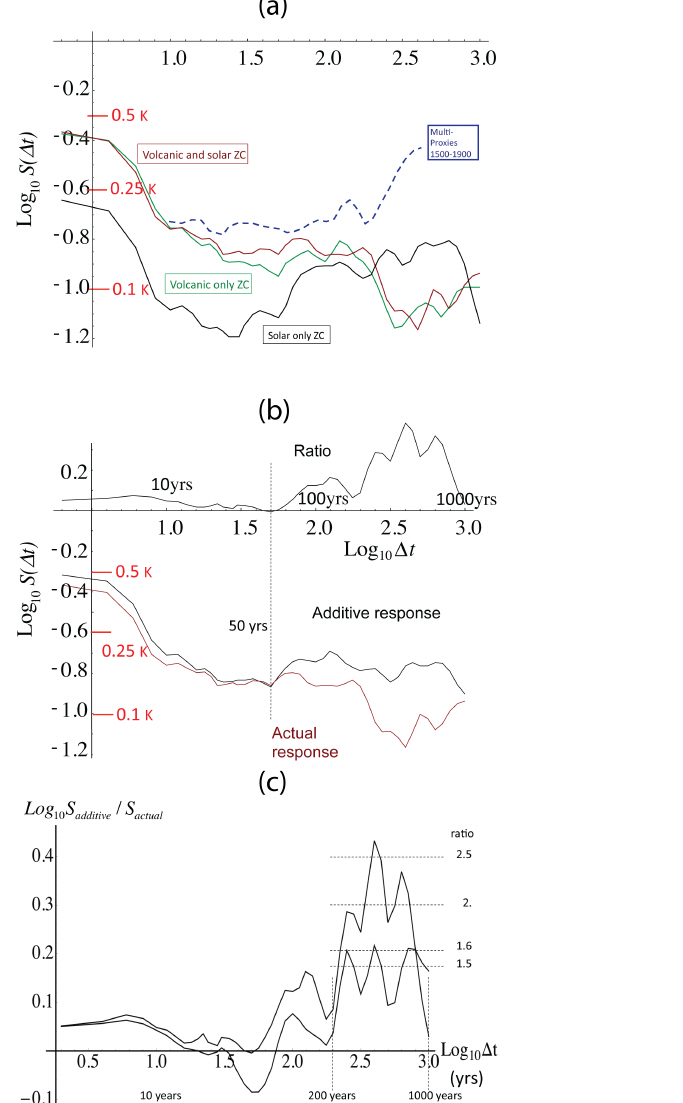
Figure 3. (a) The RMS Haar fluctuations of the Zebiak–Cane (ZC) model responses (from an ensemble of 100 realizations) with volcanic only (green, from the updated Crowley reconstruction), solar only (black, using the sunspot-based background; Wang et al., 2005), and both (brown). No anthropogenic effects were modelled. Also shown for reference are the fluctuations for three multiproxy series (blue, dashed, from 1500 to 1900, pre-industrial; the fluctuations statistics from the three series were averaged, and this curve was taken from Lovejoy and Schertzer, 2012b). We see that the combined volcanic and solar response of the model reproduces the statistics until scales of ≈ 50–100 years; however, at longer timescales, the model fluctuations are much too weak – roughly 0.1K (corresponding to ± 0.05K) and constant or falling – whereas at 400-year scales, the temperature fluctuations are ≈ 0.25K ( ± 0.125) and rising. (b) A comparison of the RMS fluctuations of the ZC model response to combined solar and volcanic forcings (brown, bottom, from a ), with the theoretical additive responses (black, bottom) as well as their ratio ( S additive /S actual black, top). The additive response was determined from the RMS of the solar-only and volcanic- only response variances (from a ): additivity implies that the fluctuation variances add (assuming that the solar and volcanic forcings are statistically independent). We can see that, after about 50–200 years, there are strong negative feedbacks, and the solar and volcanic forcings are subadditive; see (c) for an enlargement of the ratio. (c) An enlarged view of the ratio of the linear to nonlinear responses (from b ). The top curve assumes for the combined forcing, the linearity of the response and statistical independence of the solar and volcanic forcings, whereas the bottom curve uses the actual response to the combined forcings. The maximum at around 400 years (top curve) corresponds to a factor ≈ 2 ( ≈ 1.5, bottom curve) of negative feedback between the solar and volcanic forcings. The decline at longer durations ( (cid:49)t ’s) – especially the single 1000-year fluctuation – is likely to be an artefact of the limited statistics at these